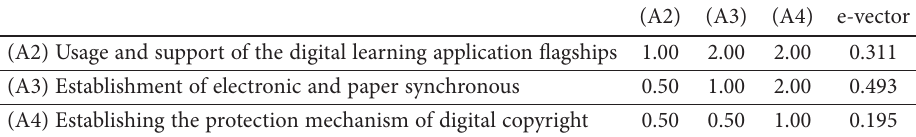
Table 3. The pair-wise comparison for requirement of “(A1) Providing financing and digital product development subsidies” under “(A) Expanding the publishing content” dimension